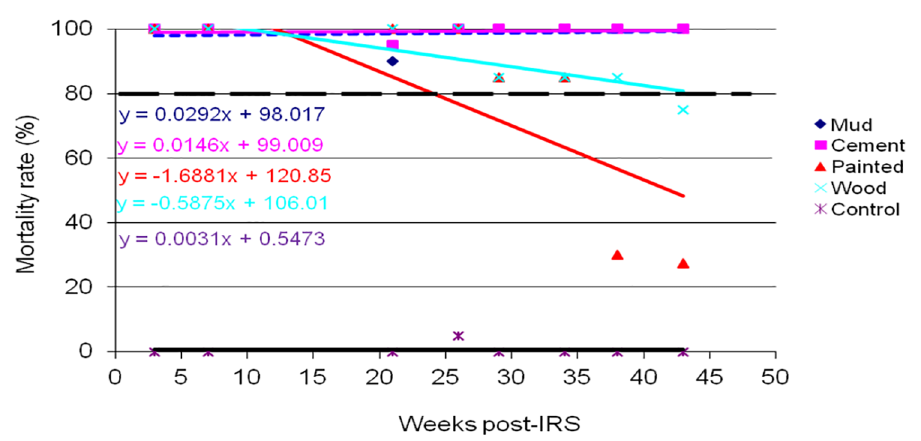
Fig 3. Cone wall bioassay response of susceptible strain An . gambiae s . s to p-methyl 300 CS sprayed in different wall surfacesin Katunguru village, Sengeremadistrict. The dashed line represents the WHO threshold of 80% mortality.